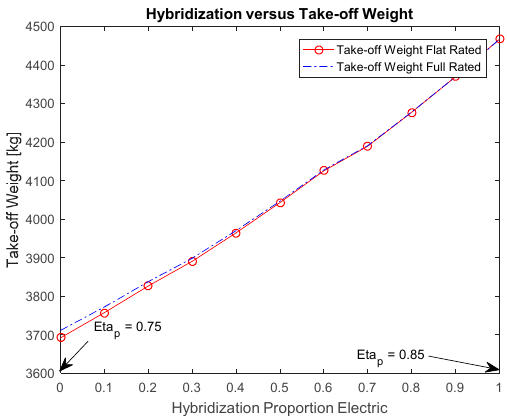
Figure 10. Take-off gross weight vs. hybrid proportion.